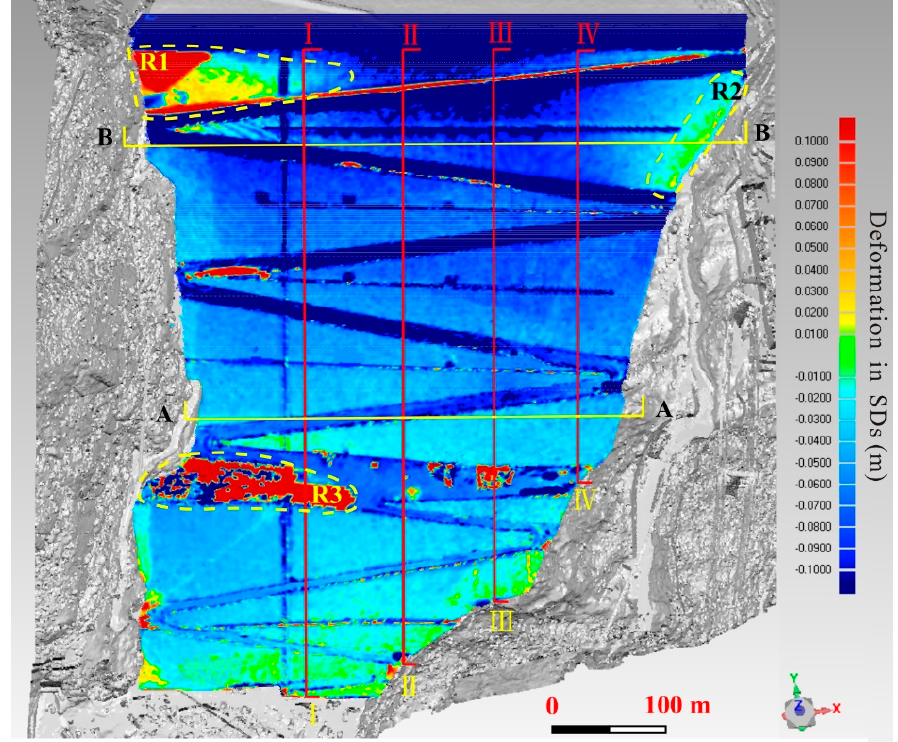
Figure 8. Deformation distribution of the Changheba dam. SDs: shortest distances.